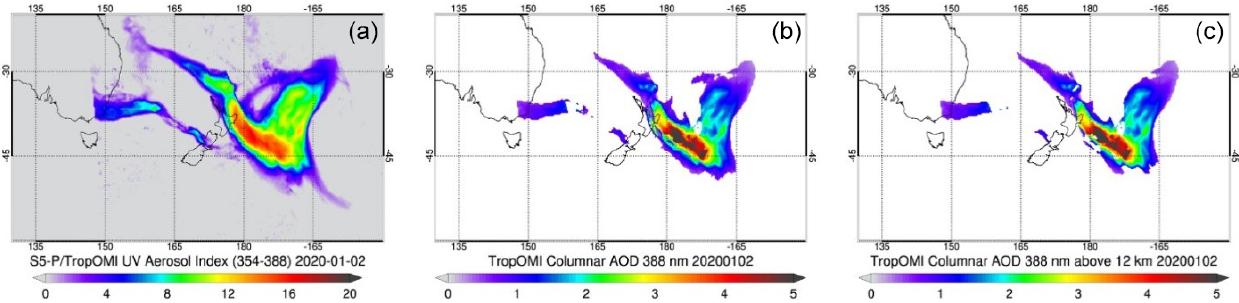
Figure 13. TROPOMI UVAI (a) , total column 388nm AOD (b) , and above 12km AOD (c) fields of Australian smoke plume on 2 Jan-